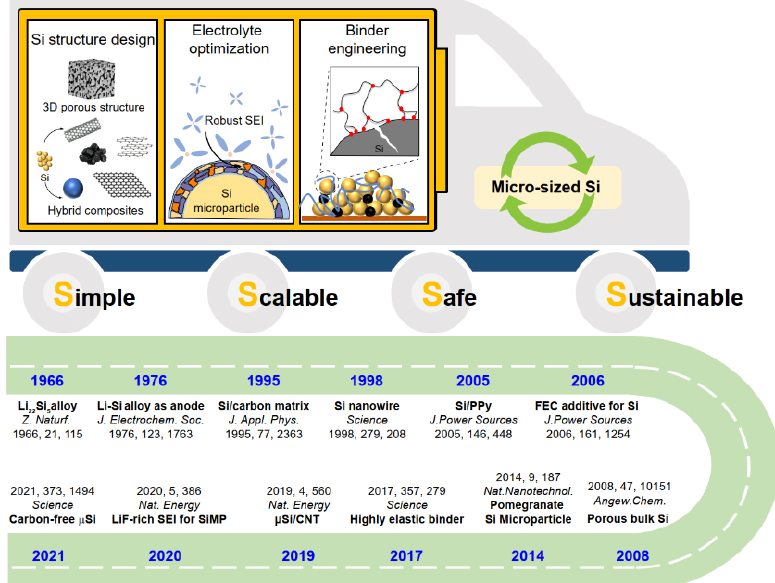
Figure 2 Overview of micro-sized Si anodes: development history of Si anodes and strategies toward